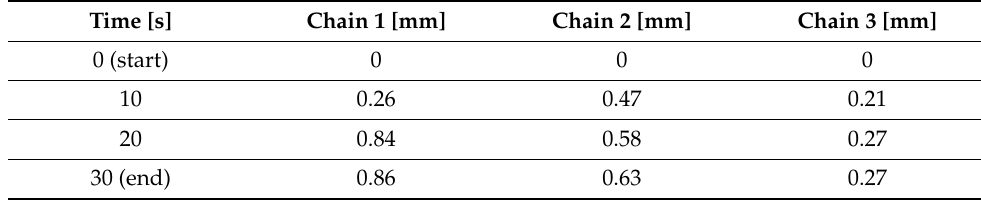
Table 3. Investigated chain length